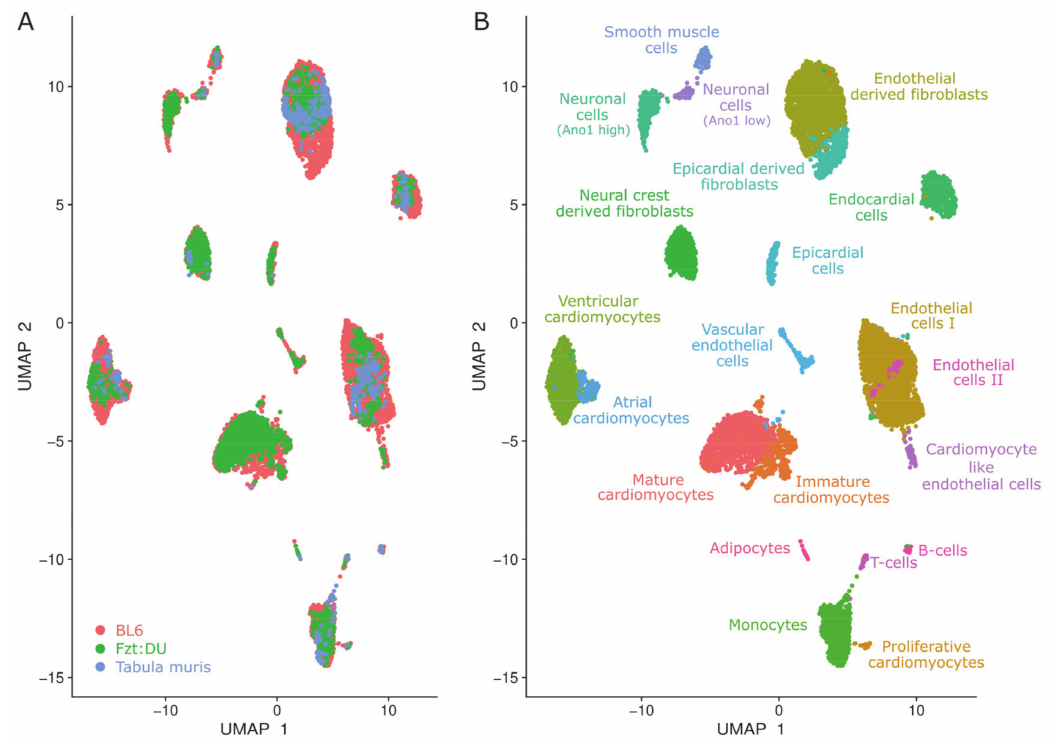
Figure 2. Uniform Manifold Approximation and Projection (UMAP) clustering of the integrated datasets representing the identified cellular clusters that are colored by data origin and cell type. ( A ) snRNA-seq data from whole Fzt:DU (green, 8533 nuclei) and BL6 (red, 3139 nuclei) mouse hearts were integrated with scRNA-seq data from hearts of BL6 mice of the tabula muris project (blue, 628 cells) to attain well-mixed clusters for a common downstream analysis. ( B ) 21 clusters were identified and annotated to specific cell